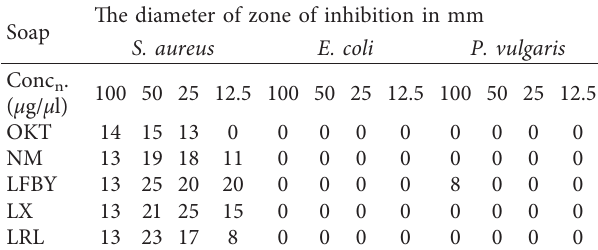
Table 5: The diameter of zone of inhibition of the pastes against three pathogenic bacteria. The diameter of zone of inhibition in Soap